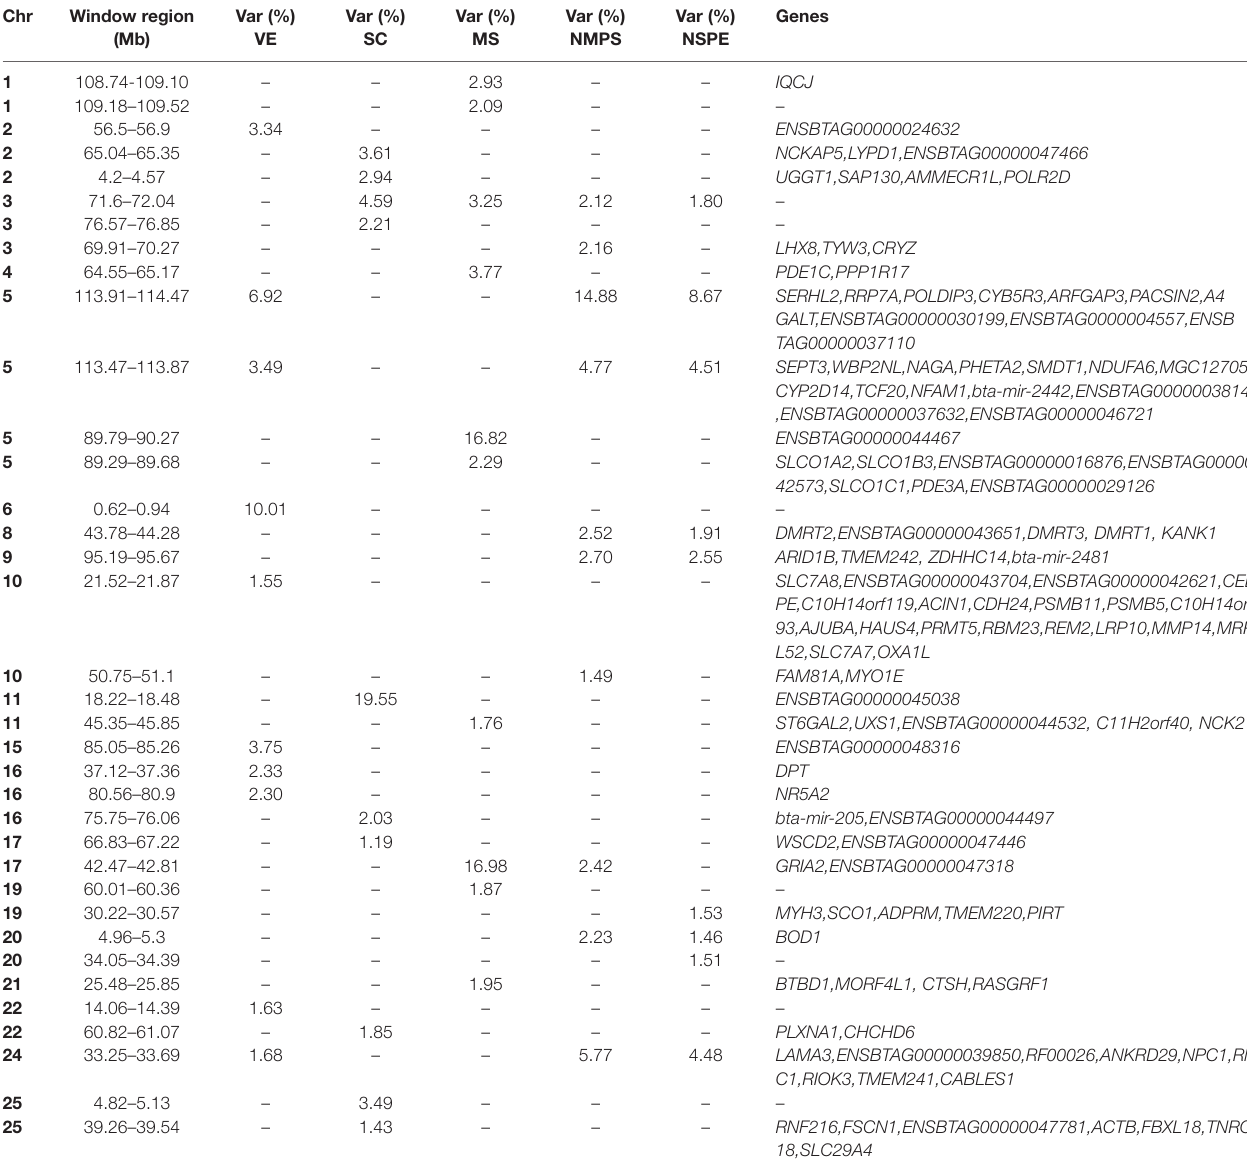
TABle 2 | Individual and overlapping of the top 10 window regions (UMD3.1) among five semen traits. Chr Window region